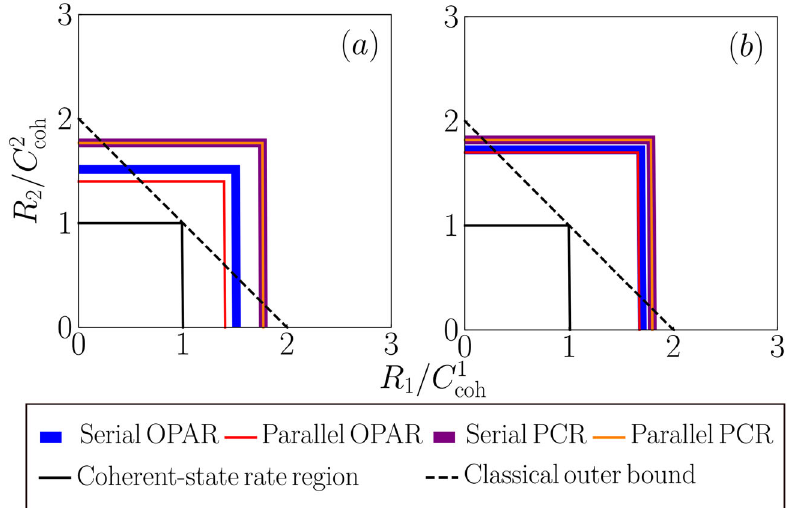
Fig. 8 The two-sender rate region of our four receivers. The rates are normalized by the coherent state bounds C 1 a microwave domain N S,1 = N S,2 = 0.01, τ = 0.01, N B = 20, η 1 = η 2 = 1/2, N R = 2 × 10 4 ; b a noisy channel with N S,1 = N S,2 = 10 − 3 , τ = 10 − 3 , N B = 10 4 , η = 1/2, N R = 10 7 . To distinguish between the overlapping lines, we plot the serial receivers in thicker lines by contrast with the parallel receivers plotted narrowed. The gains of OPAR are given in the main text, and the gains of PCR are G = 2 for N B = 20 and G = 1 + 10 − 3 for N B = 10 4 . We also compare the receiver rate region with the coherent-state rate (black solid) region and the classical outer bound (black